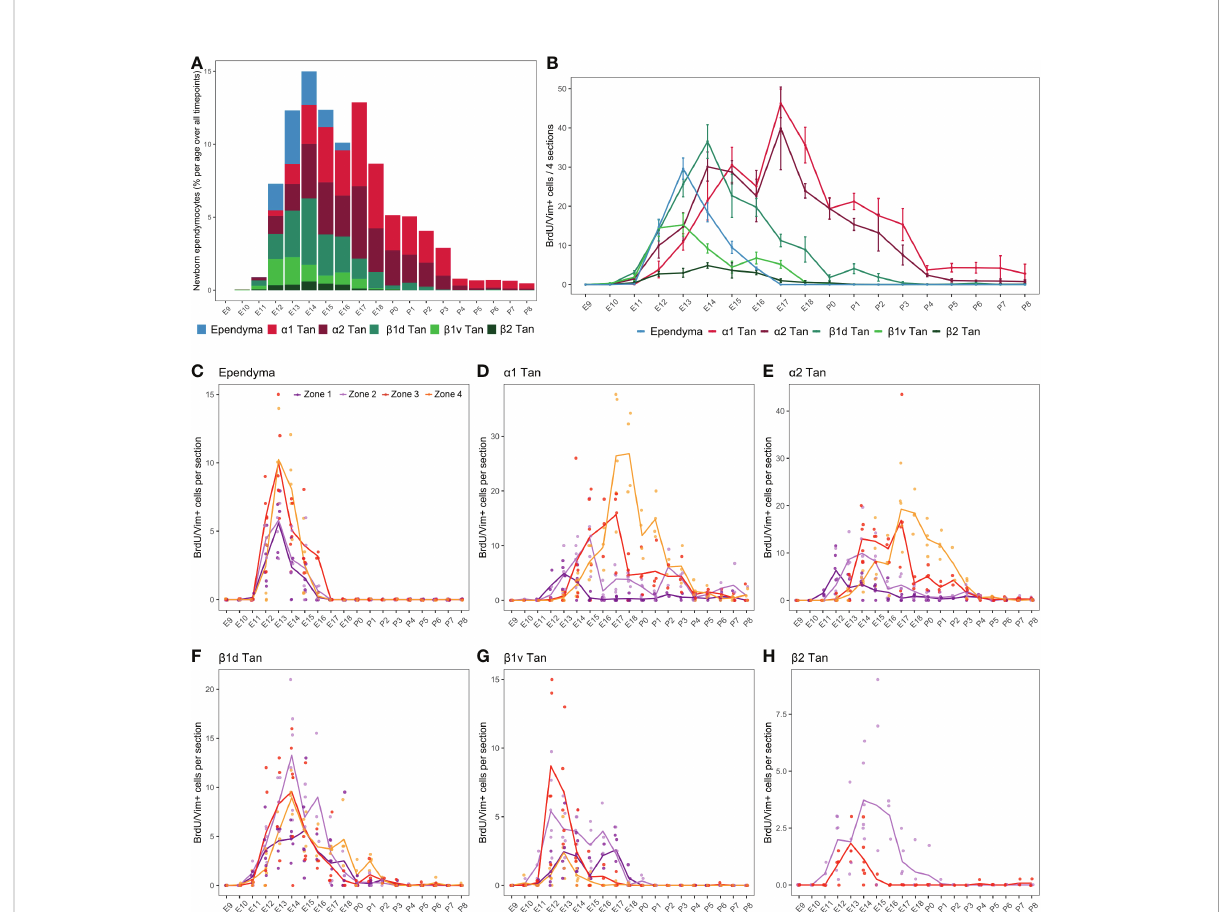
FIGURE 6 Developmental hypothalamic BrdU incorporation in vimentin (Vim)-positive cells. (A) Stacked graph displaying the proportion of newborn BrdU/ Vim-positive cells in typical ependymal and tanycyte populations per age over all analyzed brains from P21-22 animals having received a single BrdU injection from E9 to P8 ( e.g. , “ E9 ” brains were harvested from P21-22 male pups whose mothers received a single BrdU injection during pregnancy at E9; “ E10 ” brains were harvested from P21-22 male pups whose mothers received a single BrdU injection during pregnancy at E10 … ). The bars represent the percentage of cells per age over the whole analyzed period. Within a single age, the colors represent the percentage of cells per ependymal subpopulation over the whole analyzed region. (B) Number (mean ± SEM) of BrdU/Vim-positive cells per ependymal subpopulations and per age over 4 hypothalamic sections (one in each rostrocaudal zone). (C – H) Number (average -line- and individual values -dots-) of BrdU/Vim-positive cells per rostrocaudal zones (1 to 4) and per age in each ependymal subpopulation. n=3 to 7 animals per group. a 1 Tan, alpha-1 tanycytes; a 2 Tan, alpha-2 tanycytes; b 1v Tan, ventral beta-1 tanycytes; b 1d Tan, dorsal beta-1 tanycytes; b 2 Tan, beta-2 tanycytes. See Figure